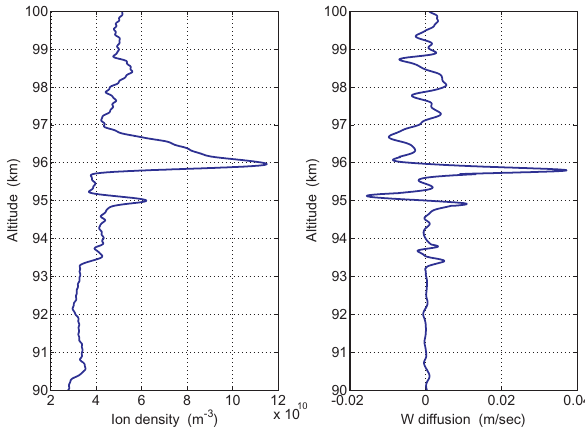
Fig. 7. Observed ion density (left panel) and corresponding vertical ion motion (right